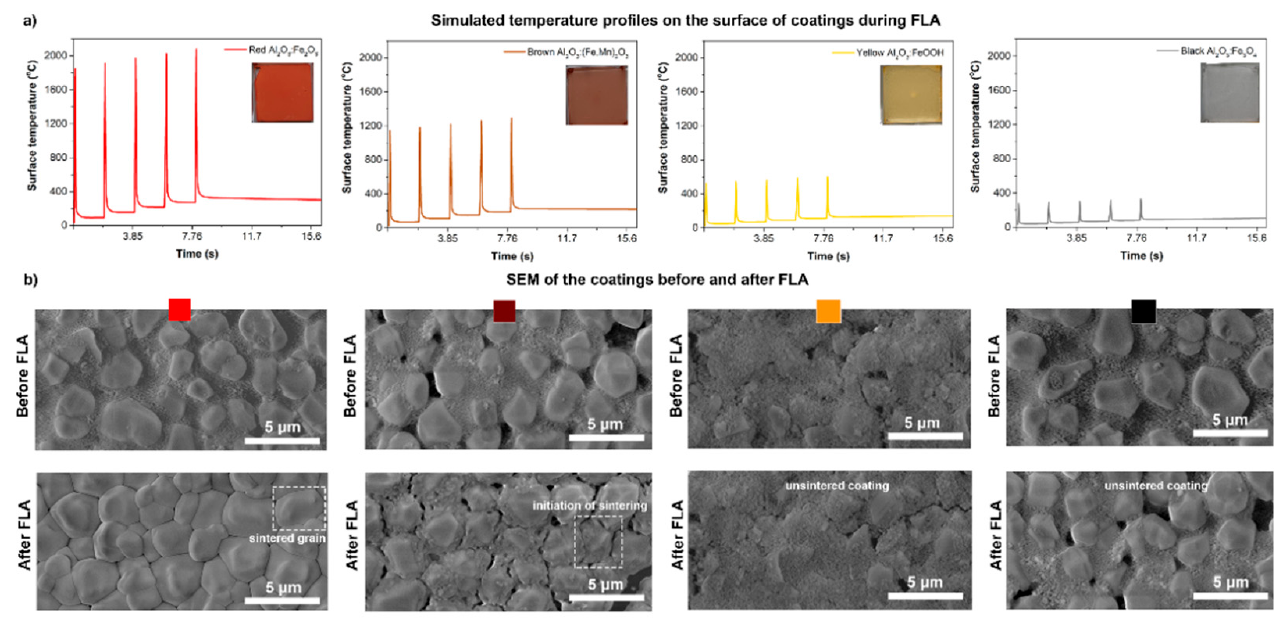
Figure 3. Compositional analysis of the ceramic films before and after FLA: ( a ) simulated temperature profiles on the surfaces of different films obtained using SimPulse software; ( b ) top-view SEM images of the ceramic films before and after FLA for various pigments, demonstrating that the most pronounced sintering occurred for the red α -Fe 2 O 3 pigment.